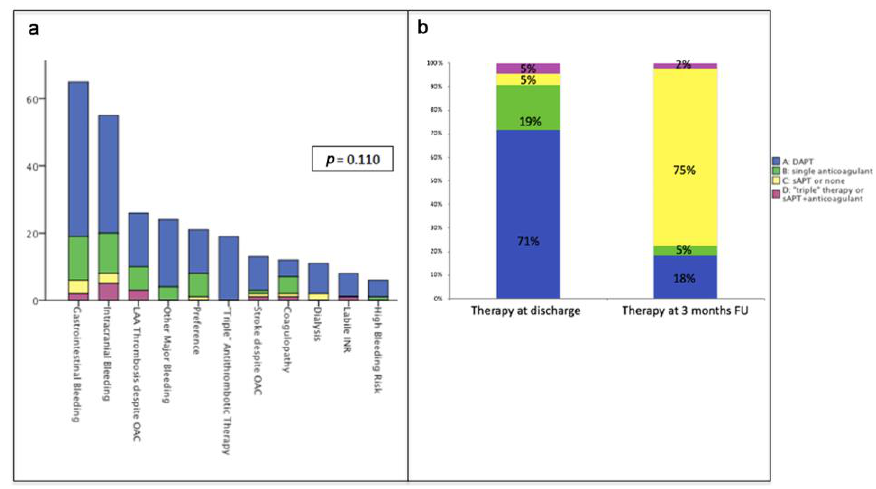
Figure 1. Figure ( a ) describes distribution of therapies at discharge based on indications to left atrial appendage (LAA) occlusion. Figure ( b ) shows therapies at discharge and after change after first follow-up evaluation (74 days, IQR 50-107). OAC = oral anticoagulation; INR = international normalized ratio; DAPT: double antiplatelet therapy; sAPT: single antiplatelet therapy. Procedural data are reported in Table 2. A total of 82 patients (32%) were implanted with a Watchman device, 5 (2%) with a Watchman FLX, 55 (21%) an Amplatzer Cardiac Plug, and 118 (45%) an Amplatzer Amulet. Technical success was reached in all patients (100%). In 11 procedures, the device was repositioned and in 5 cases device size was changed during the procedure. Devices implanted, n Table 2. Procedural data. GROUP A dual antiplatelet therapy; GROUP B anticoagulant therapy; GROUP C single an- tiplatelet therapy or no therapy; GROUP D combination of antiplatelet and anticoagulant therapy.